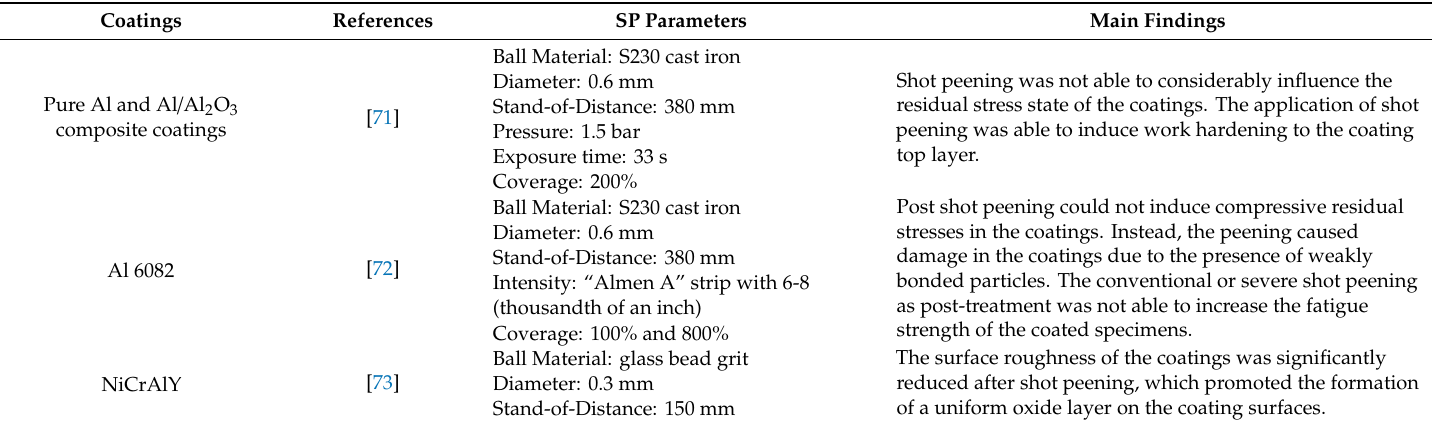
Table 3. E ff ect of shot peening on cold sprayed